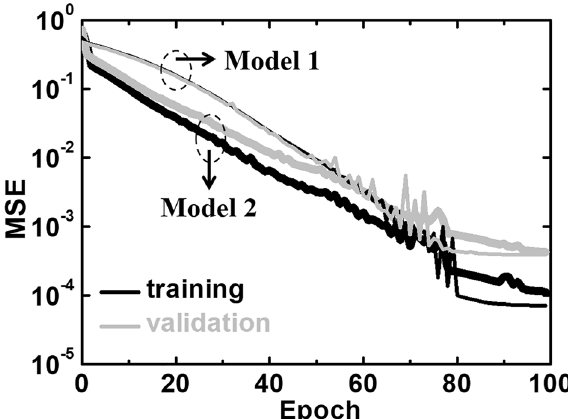
Figure 2. Training (black) and validation (grey) errors as functions of the learning epoch for Model 1(thin lines) and 2 (thick lines) trained by our U-Net. There are 200 steps in each